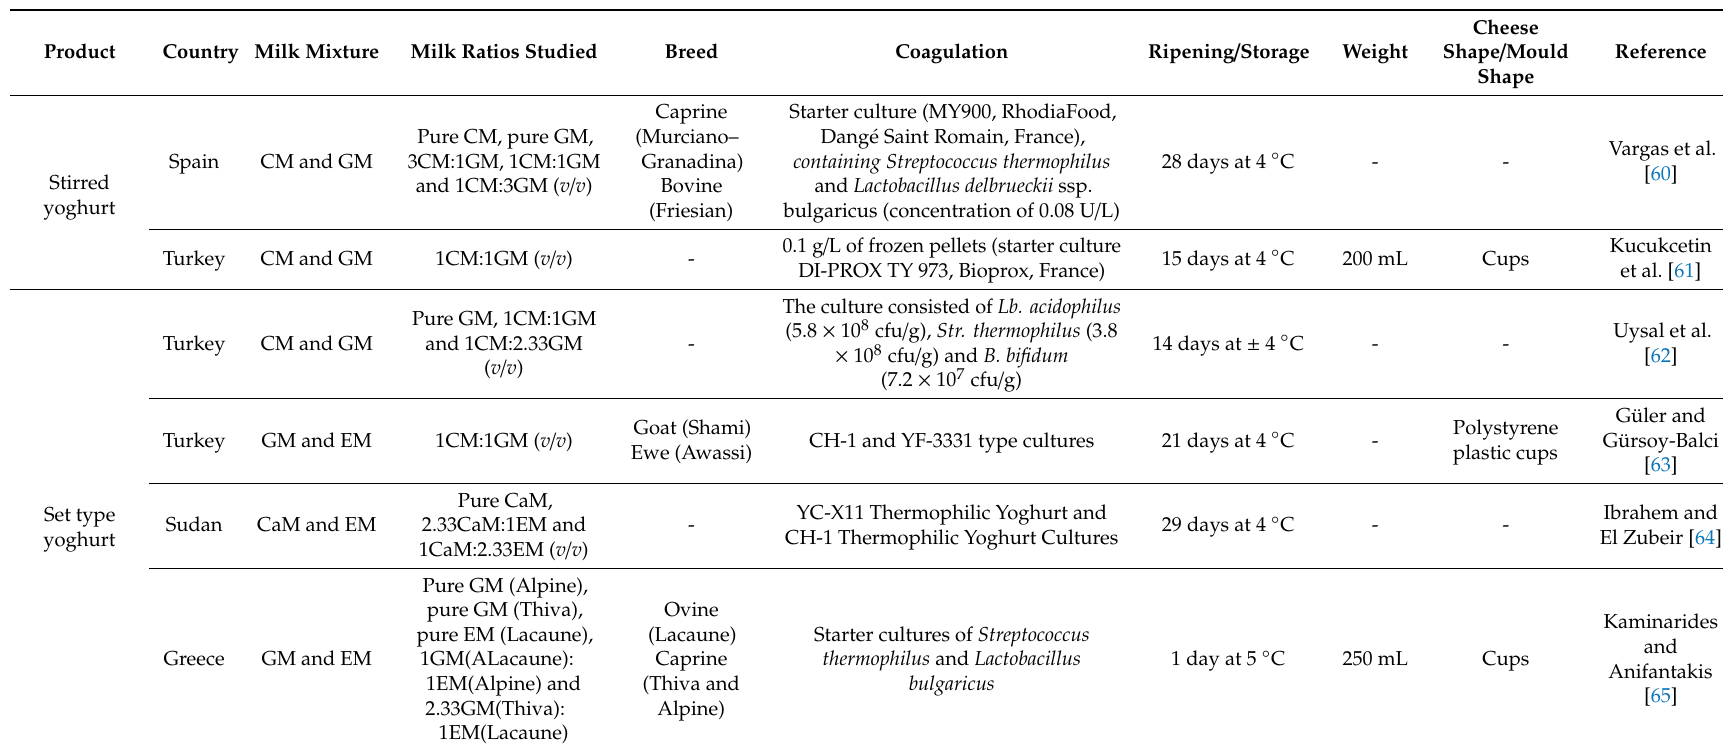
Table 2. A summary overview of some studies conducted on yoghurts containing mixtures of milk coming from di ff erent animal